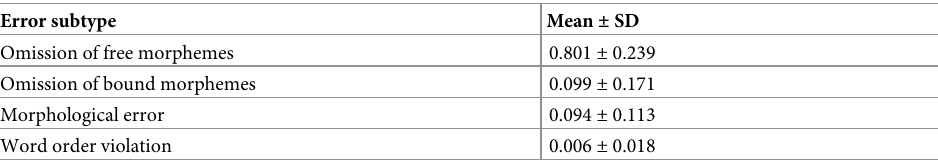
Table 4. Descriptive statistics of error subtypes.